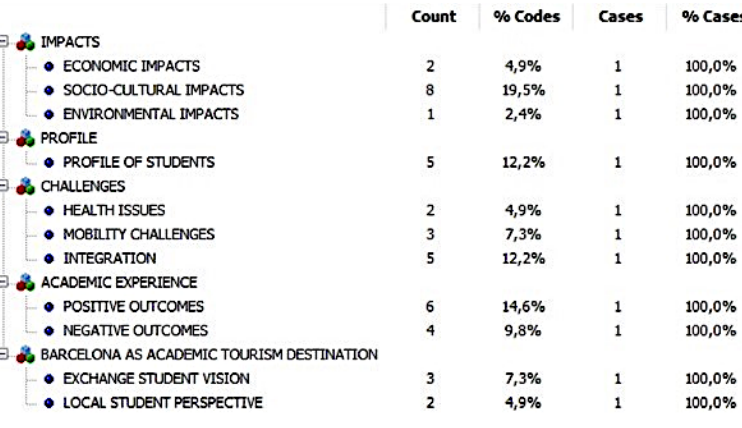
Figure 5: QDA Miner analysis of students’ focus